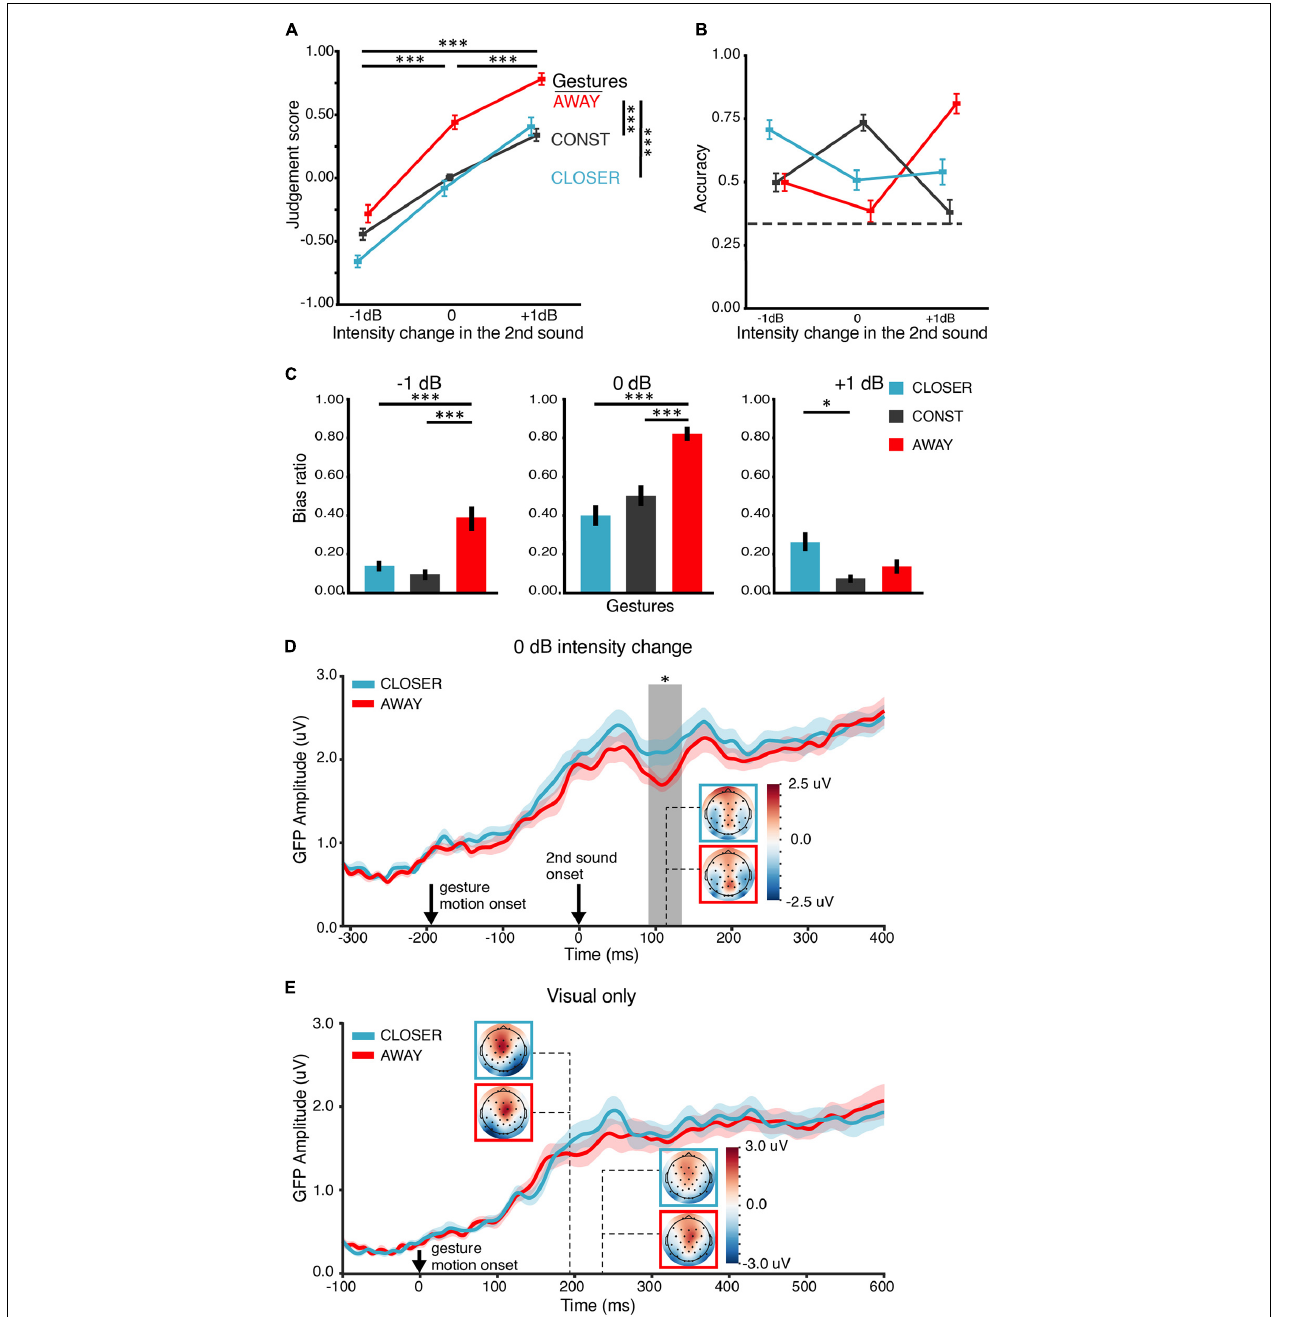
FIGURE 4 | Results of EE1. (A) Judgment score. Behaviorally, both gesture and intensity change positively affected the judgment of loudness changes. The main effects were similar to the results in BE1 in Figure 2A . (B) Accuracy of the behavioral judgment about intensity change. An interaction between the factors of gesture and intensity change was observed, consistent with the main results in BE1 in Figure 2B . The dashed line indicates the chance level (0.33). (C) Bias ratios. The judgment was biased toward the “matched” gesture 0-dB-intensity-change conditions. (D) ERP responses to the second sound in the 0-dB-intensity-change conditions were modulated by the gestures. Gesture CLOSER elicited a stronger ERP response than gesture AWAY at around 110 ms after the onset of the second sound. Solid lines in each plot indicate the grand mean global field power (GFP) waveform. The shades around the lines represent +, – one SEM ( n = 21). Response topographies are shown in colored boxes with dashed lines pointing to their latencies. The colored boxes use the same color schemes as the waveform responses to indicate different conditions. The gray vertical rectangular shade indicates the temporal cluster (91–135 ms) in which the two GFPs were significantly different in the temporal cluster analysis. (E) ERP responses to video stimuli in the visual-only (V) conditions. The visual ERP responses to gesture CLOSER and AWAY were not significantly different, suggesting that different visual stimuli evoked similar early visual responses and the observed effects in panel (D) were not caused by different visual gesture stimuli. The depicting formats are the same as in panel (D) . The error bars indicate ± one SEM. ∗ p < 0.05; ∗∗ p < 0.01; ∗∗∗ p < 0.001.